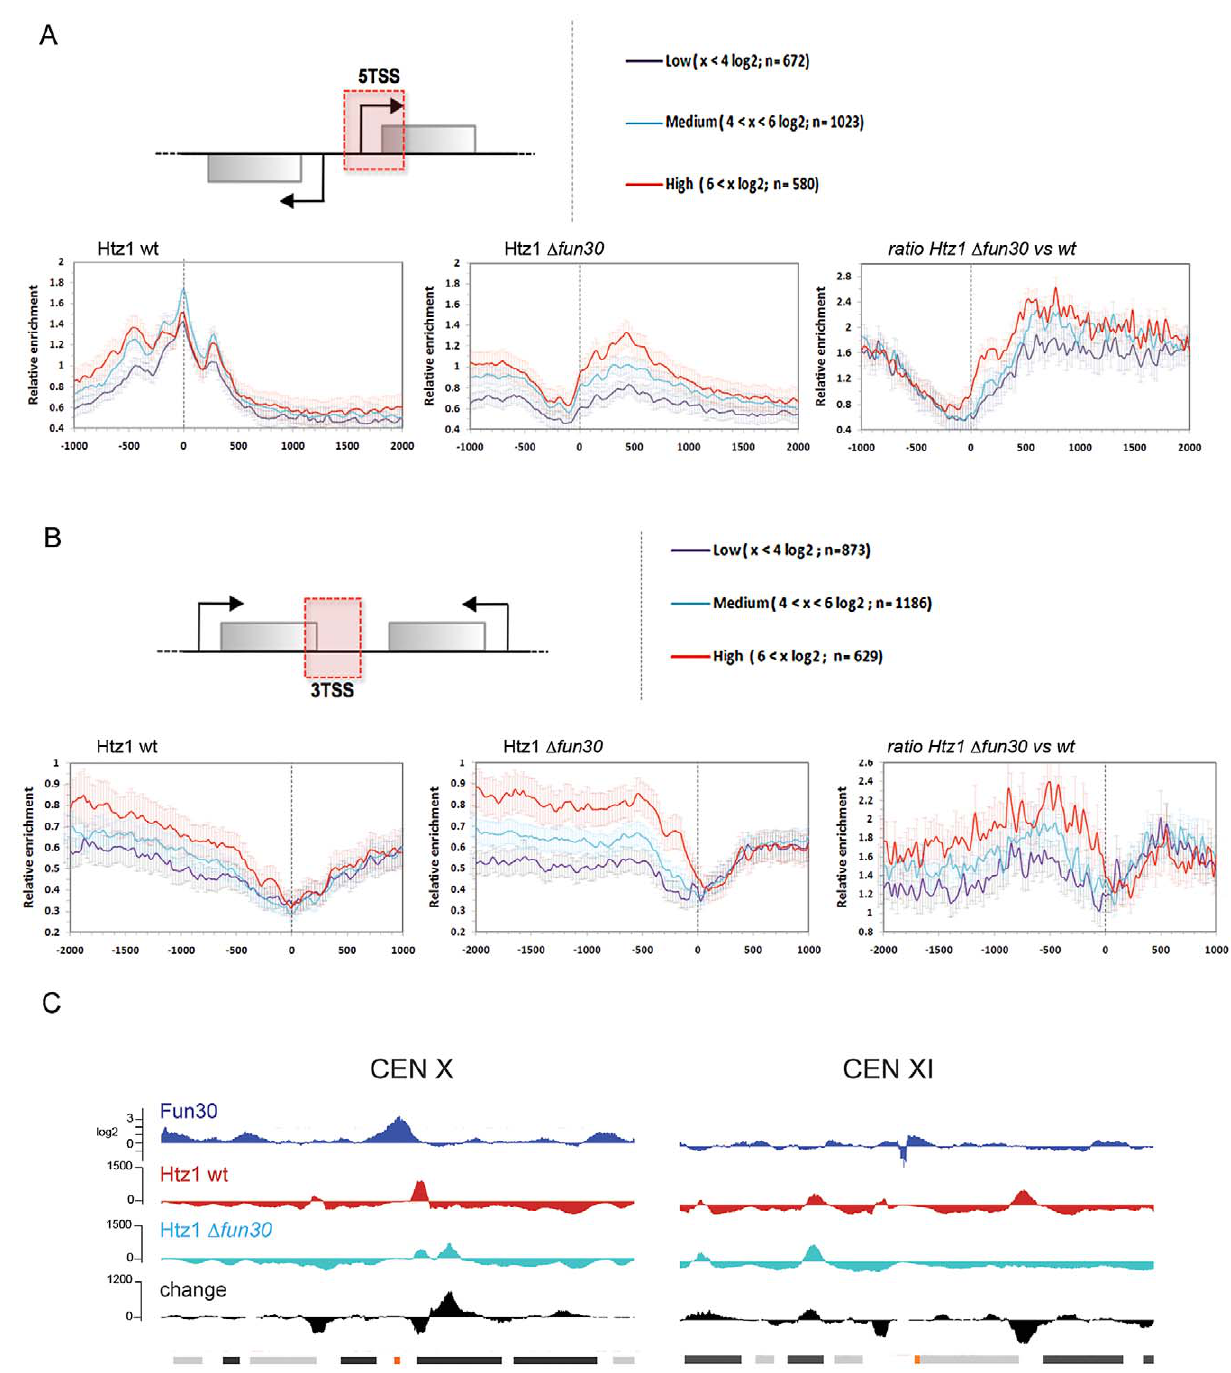
Figure 9. Fun30 affects Htz1 occupancy, including at centromeres. (A) Average occupancy analysis for histone Htz1 for divergent orientation genes relative to the 5 9 Transcription start site (5TSS) position for wildtype cells (left panel), D fun30 cells (middle panel) and ratio D fun30 versus WT (right panel, W303 3Myc-Htz1 versus W303 3Myc-Htz1 D fun30 ). (B) Average occupancy analysis for histone Htz1 for convergent orientation genes relative to the 3 9 Transcription stop site (3TSS) position for wildtype cells (left panel), D fun30 cells (middle panel) and ratio D fun30 versus wildtype. (C) Effect of Fun30 on Htz1 occupancy 5 kbp up- and downstream of CEN10 and CEN11 . Shown is the Fun30 occupancy as measured by ChIP-seq in the top lane (dark blue, log 2 scale, expressed as ratio of normalized sequence tag counts from ChIP to input). Htz1 occupancy from wildtype (wt, red) and D fun30 (light blue) are shown in the two lanes below expressed as normalized sequence tag counts corrected for input in linear scale. The change in occupancy of Htz1 is indicated in the lane below as the values from the D fun30 cells minus the values from wt cells (black). Positions of ORFs and centromeres are indicated in the lowest lane, orange box: centromere, back and grey boxes: ORFs in the sense and antisense direction, respectively.